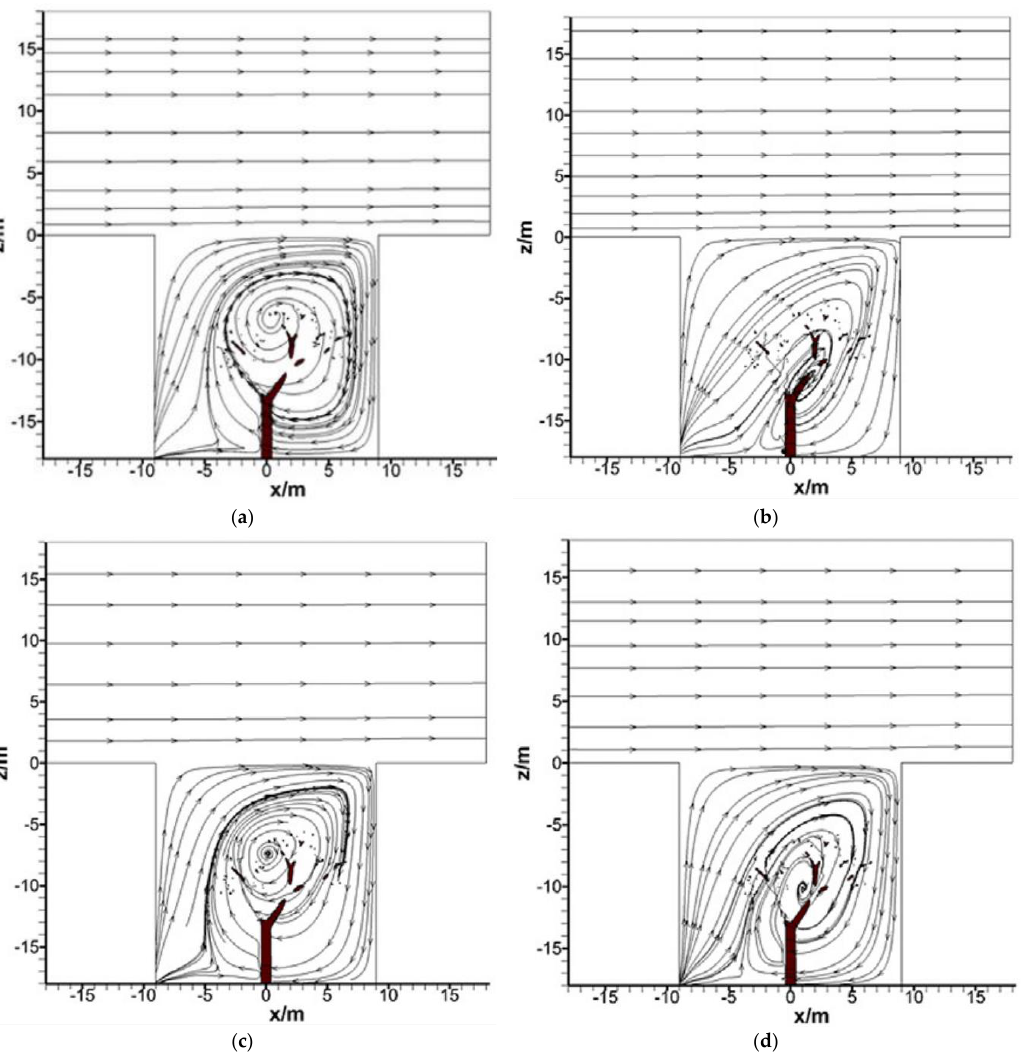
Figure 2. Streamlines at the y = −0.7 m section in canyon at different inflow wind velocities [23]. ( a ) 0.7 m/s. ( b ) 1.7 m/s. ( c ) 3.7 m/s. ( d ) 5.7 m/s.